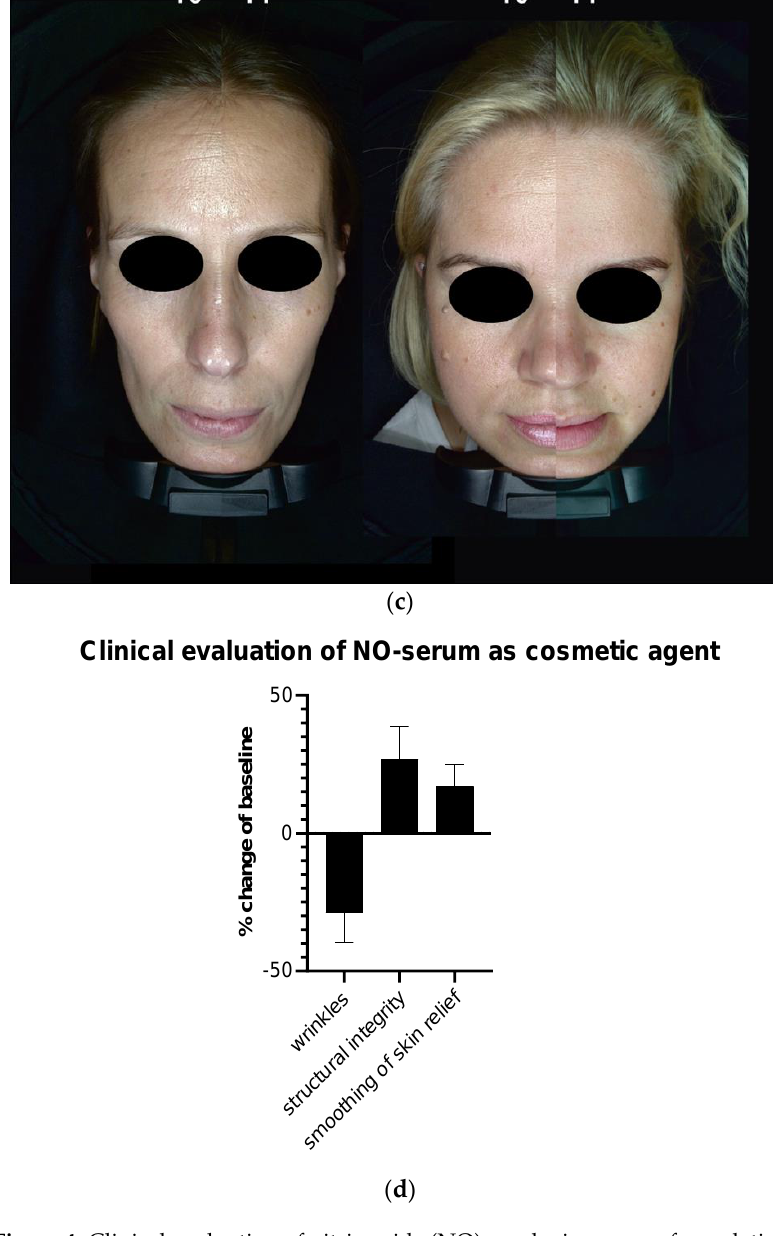
Figure 4. Clinical evaluation of nitric oxide (NO)-producing serum formulation as cosmetic agent. ( a ) Four weeks (T1) of application reduced wrinkles and dry lines significantly. ( b ) Four weeks of application furthermore increased structural integrity and led to ( c ) an overall smoothing of skin relief. Overall changes are displayed in ( d ). Scale bars: 50 µm. Table 1. Results of the efficacy questionnaire.